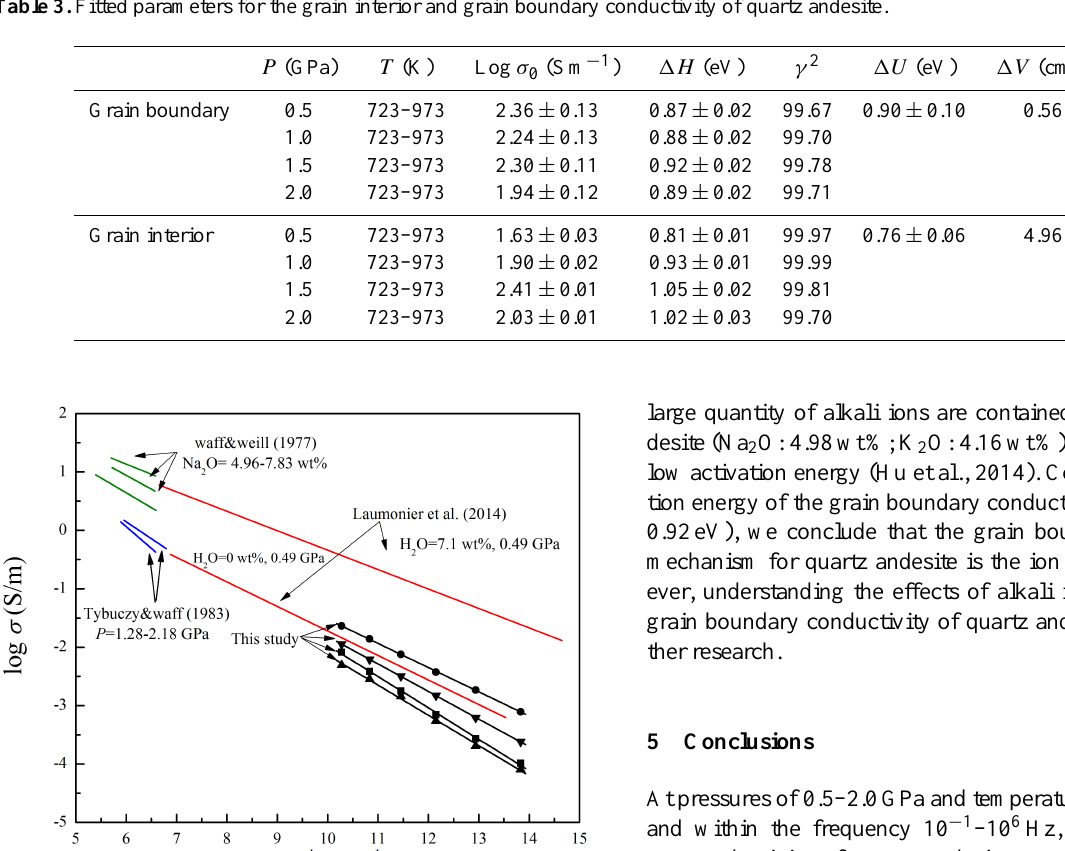
Table 3. Fitted parameters for the grain interior and grain boundary conductivity of quartz andesite.